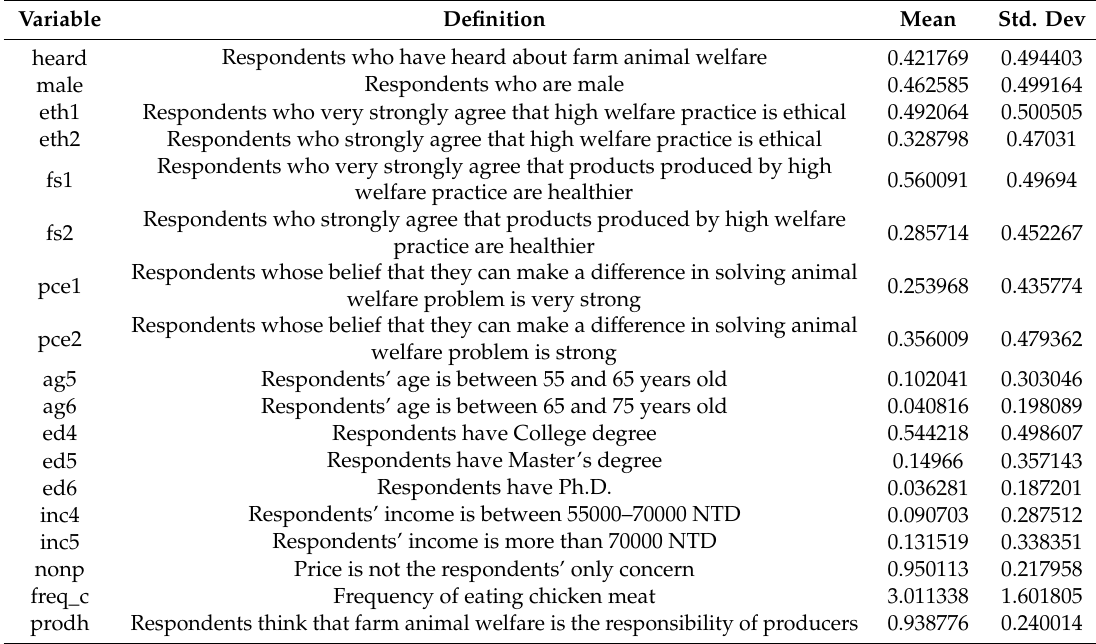
Table 1. Descriptive